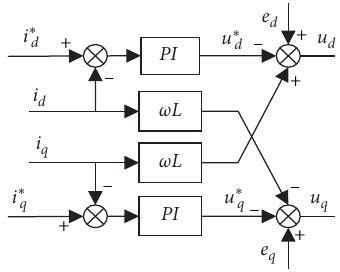
Figure 5: Control diagram of feedforward decoupling.